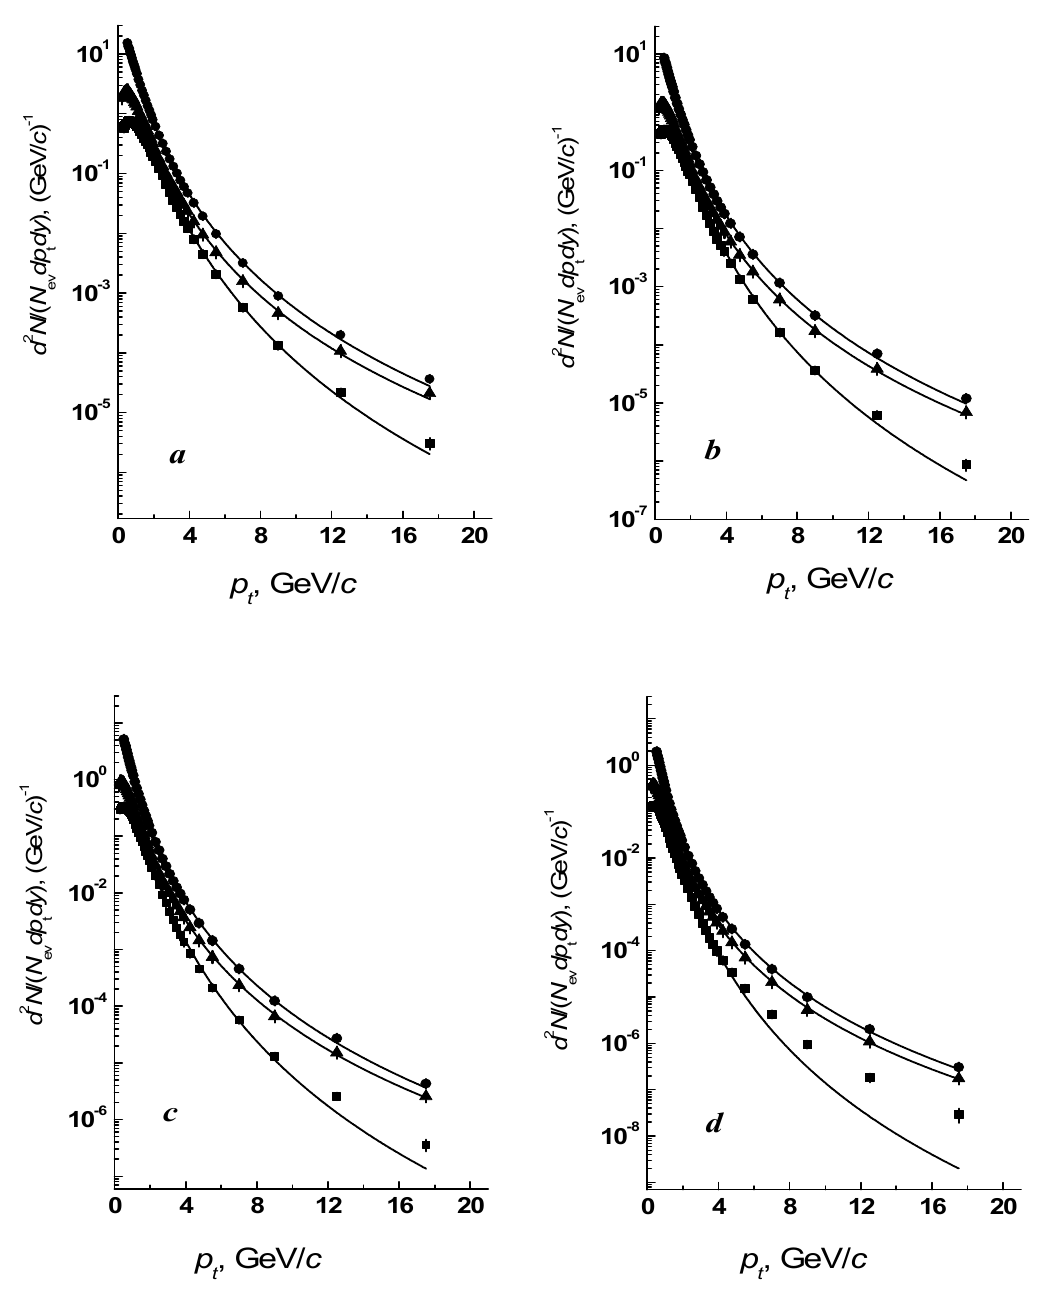
Figure 2. The combined minimum 𝜒2 fits (solid curves) with the function in Equation (7) of the experimental mid- y p t distributions of the charged pions ( ● ) and kaons ( ▲ ), protons and antiprotons ( ■ ) in proton–proton collisions at ( s ) 1/2 = 7 TeV in various groups of < dN ch / d η >: < dN ch / d η > = 21.3 ± 0.6 ( a ), < dN ch / d η > = 11.5 ± 0.3 ( b ), < dN ch / d η > = 6.72 ± 0.21 ( c ), and < dN ch / d η > = 2.26 ± 0.12 ( d ). The vertical error bars are combined statistical and systematic errors, dominated by the systematic ones.